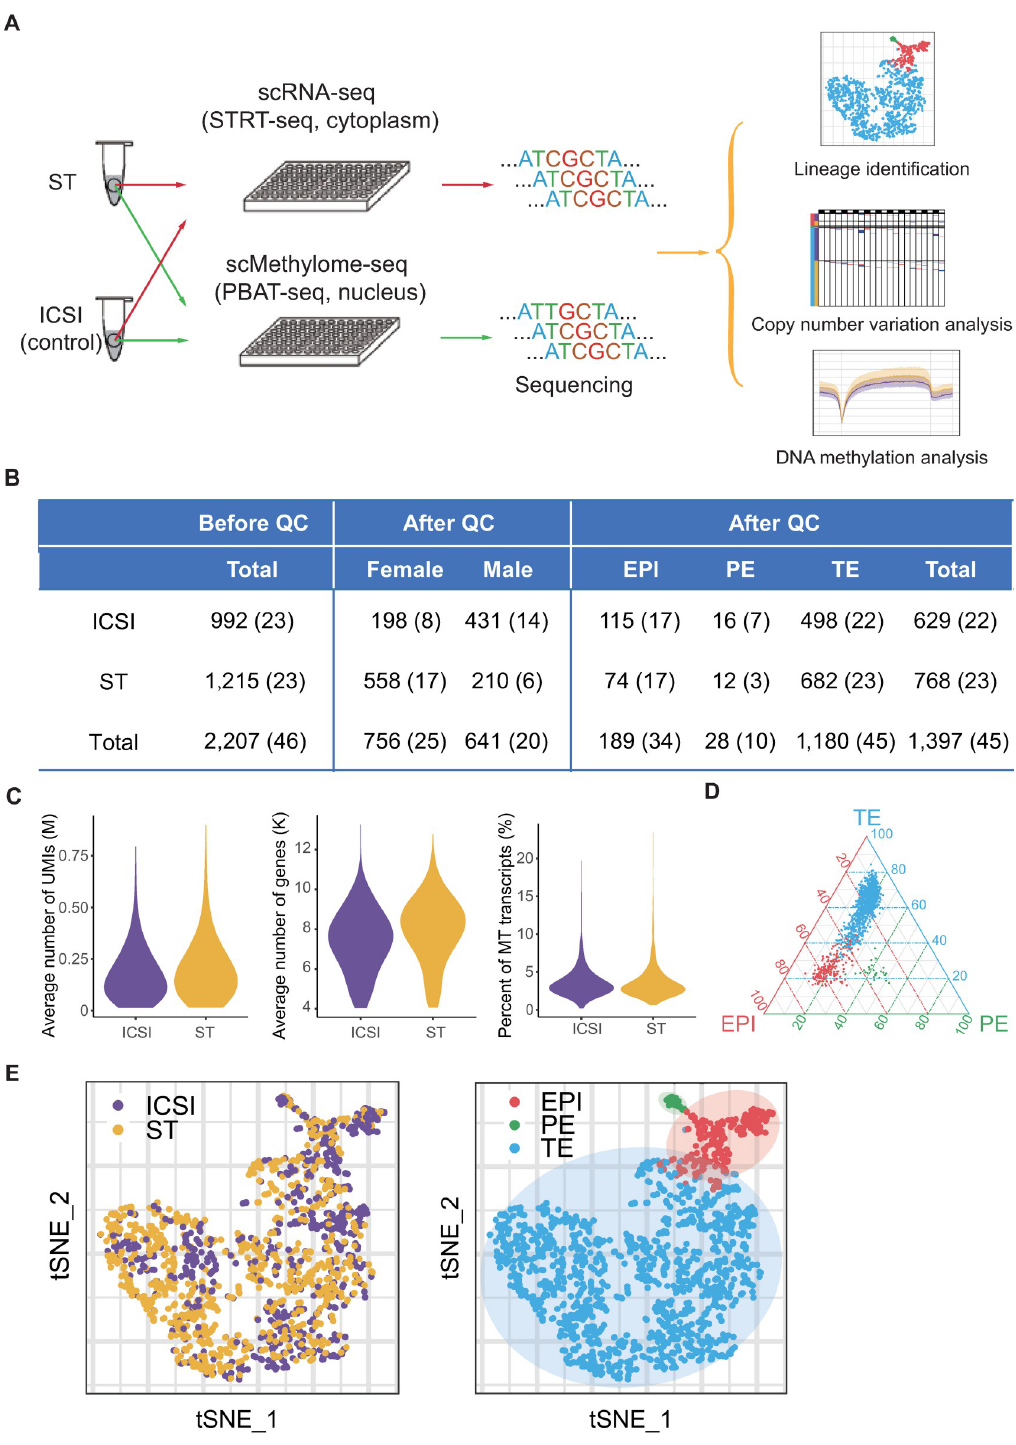
Fig 1. Single-cell Trio-seq2 sequencing of spindle-transferred human embryos. (A) Schematic of single cell collection, transcriptome sequencing, and DNA methylome sequencing and analysis. (B) Summary of the number of cells and embryos before and after quality control for the ICSI and ST groups. (C) Average number of UMIs and genes and percentage of MT transcripts in 1,397 cells passing quality control. (D) Ternary plots of lineage scores. (E) A total of 1,397 cells retained after quality control projected onto a t-SNE map and colored according to group (left) and lineage (right). The numerical data are listed in S1 Data. EPI AU : AbbreviationlistshavebeencompiledforthoseusedinFigs 1 (cid:0) 5 : Pleaseverifythatallentriesarecorrect : , epiblast; ICSI, intracytoplasmic sperm injection; MT, mitochondrial; PBAT-seq, post-bisulfite